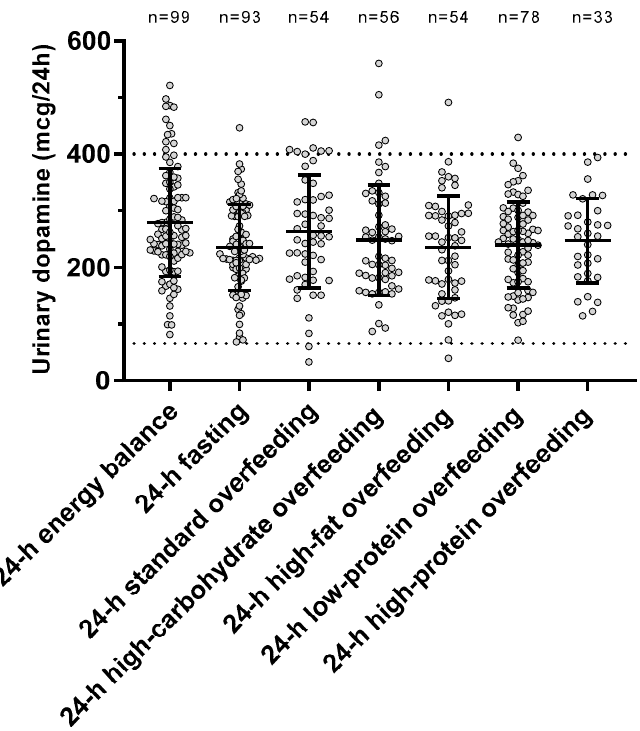
Figure 2. Urinary dopamine excretion rate during each 24-h dietary intervention. Error bars represent mean ± SD. The dotted lines represent the normal range for urinary dopamine (65–400 mcg/24 h) based on Mayo Clinic laboratory reference ranges for catecholamines (https://neurology.testcatalog.org/show/CATU accessed on 15 March 2021). Table 2. Urinary dopamine excretion rates during 24-h fasting and different overfeeding diets.